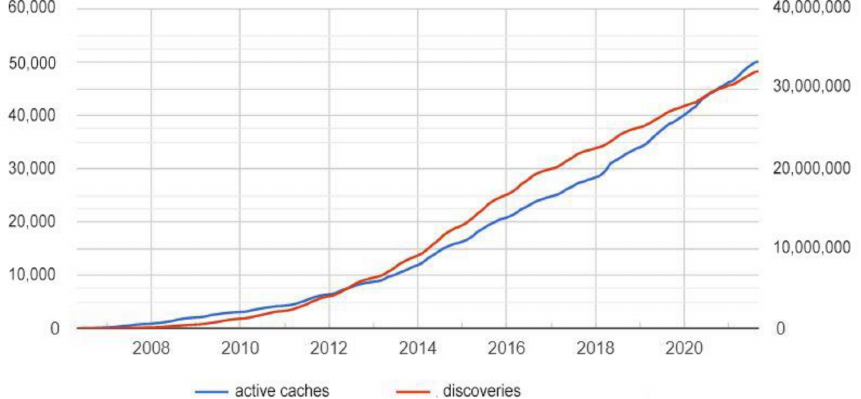
Figure 18. Statistics of active caches and the number of discoveries in Poland. by M. Rudnicka-Bogusz based on data from the website www.opencaching.pl (accessed